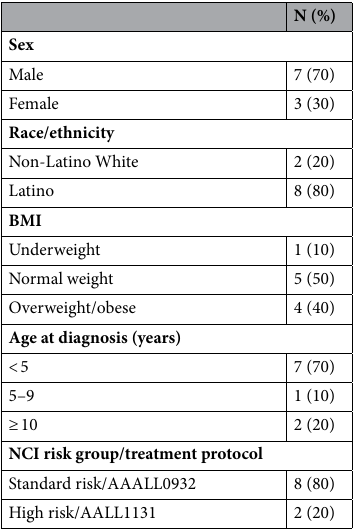
Table 1. Demographic and clinical characteristics of B-ALL patients in the study